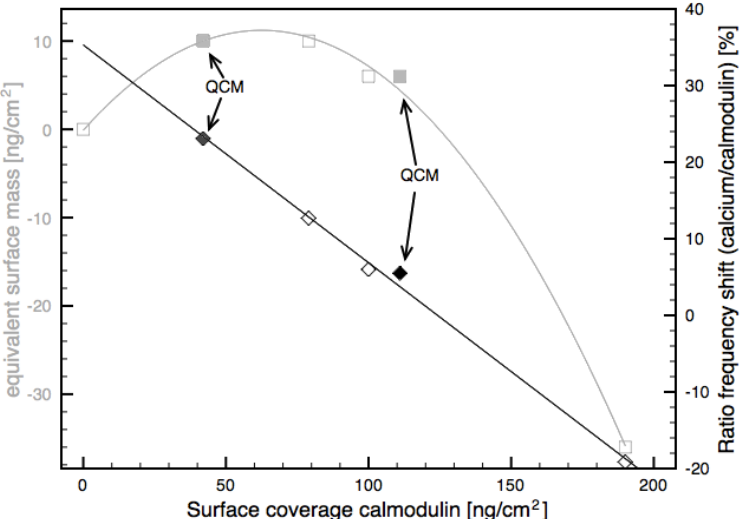
Figure 3. Frequency response caused by calcium adsorption for different surface densities of calmodulin. Ratio of the frequency shift of the calcium adsorption to the frequency shift of the calmodulin adsorption is plotted in black. Equivalent surface mass calculated from the frequency shift is plotted in grey. Values for the QCM were taken from [15,16]. A line was fitted through the points showing the ratio of the frequency shifts and parabola through the points showing the equivalent surface